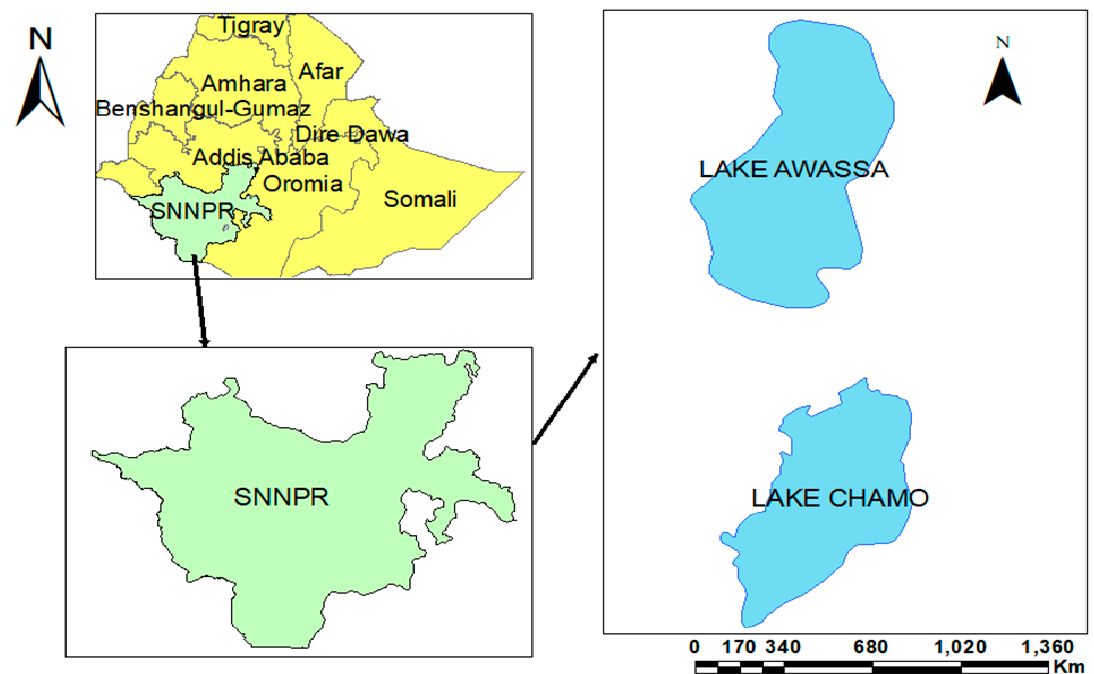
Figure 1. Study area. SNNPR: South Nation Nationality Peoples Region.